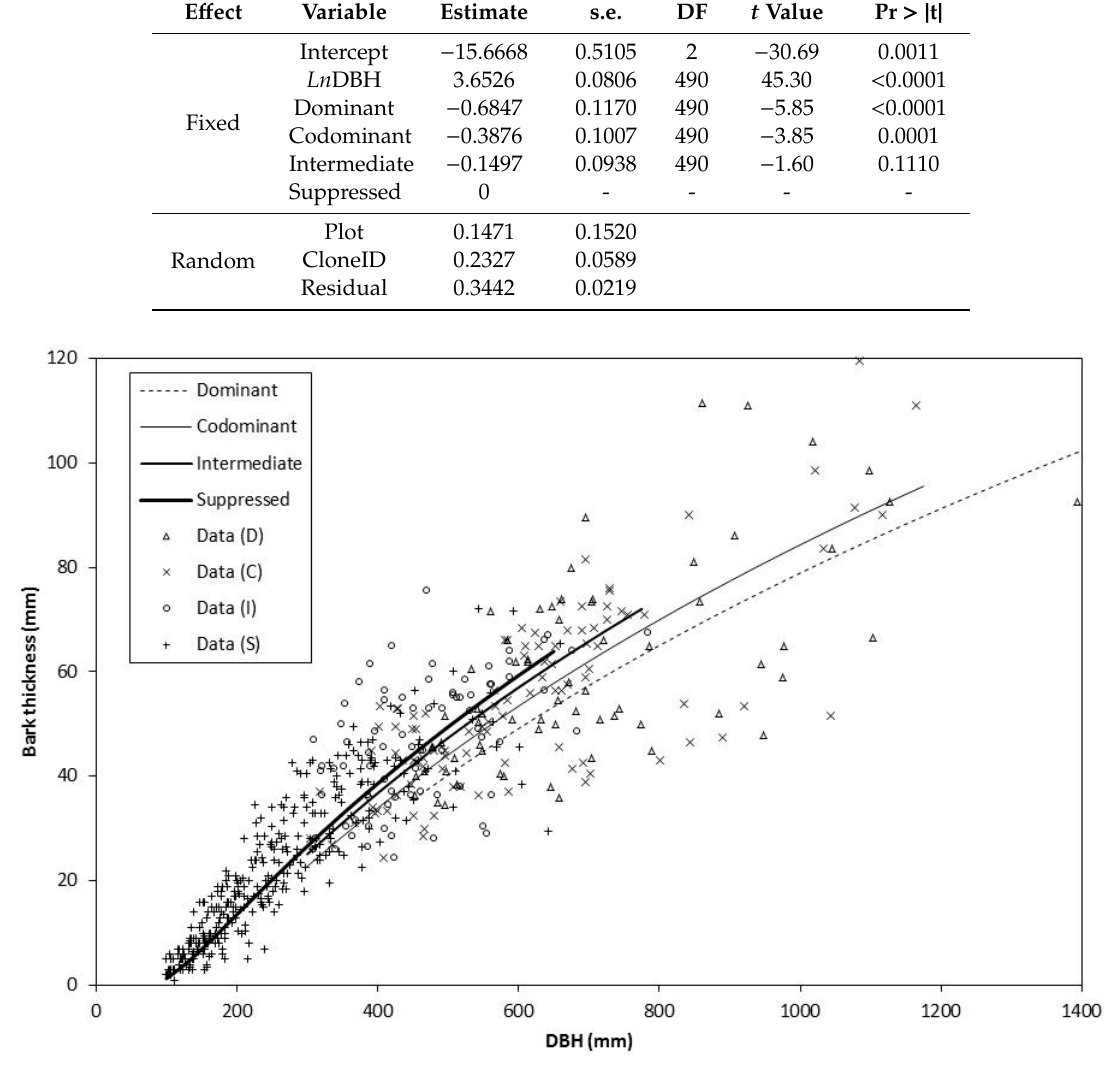
Figure 2. Redwood bark thickness data and linear mixed-effects model predictions for each crown class at age 85 years in three even-aged stands in Jackson Demonstration State Forest.